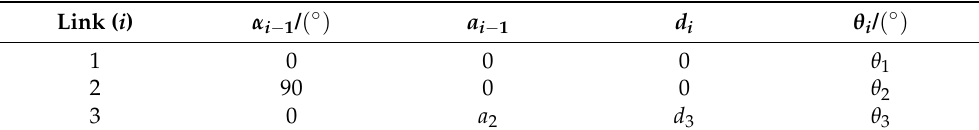
Table 4. D–H parameter table.